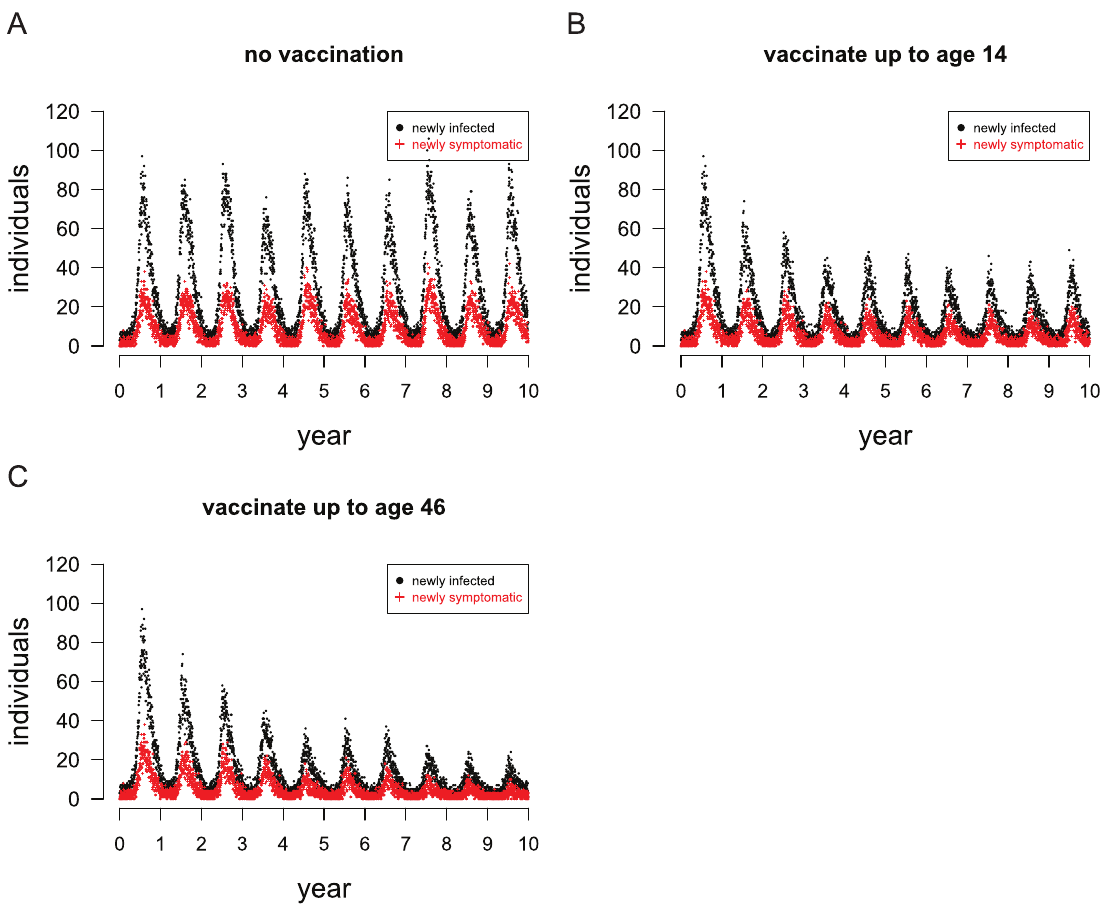
Figure 7. The simulated effect of vaccination on daily infection and illness incidence over ten years. (A) No vaccination. (B) Vaccine roll- out that covers only children ages 2 to 14 years. (C) Vaccine roll-out that covers children and adults ages 2 to 46 years. 70% of each age cohort is vaccinated, and the vaccine confers all-or-none protection to 70% of vaccinees. The points indicate the number of newly infected or symptomatic people during a single day in a single representative stochastic simulation.